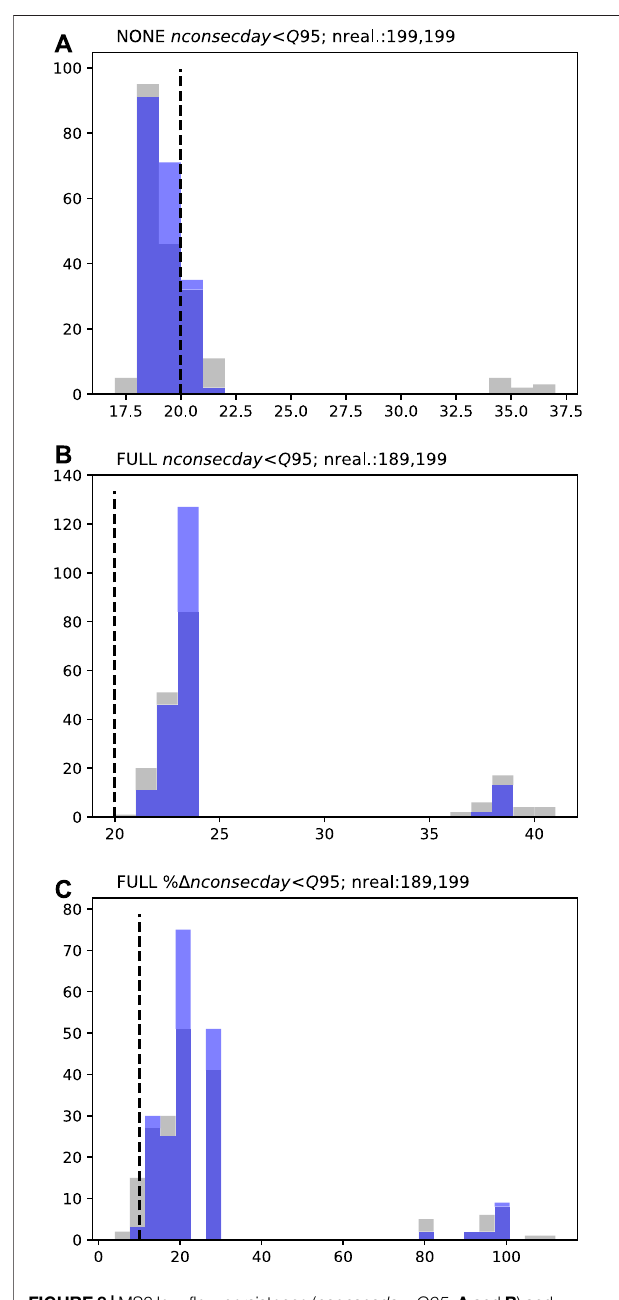
FIGURE8 | MS2 low- fl ow persistence ( nconsecday < Q95; A and B ) and percentchange low- fl owpersistence ( %nconsecday < Q95; C ) prior (grey) and posterior (blue) forecast PDFs. Dashed black lines represent the respective decision thresholds (20 days in A and B and 10% change in C ). “ NONE ” represents the “ naturalized ” baseline and “ FULL ” the abstraction scenario. “ nreal. ” details the number of successful realizations (therefore the number of data points represented in the PDF) for prior and posterior ensembles,